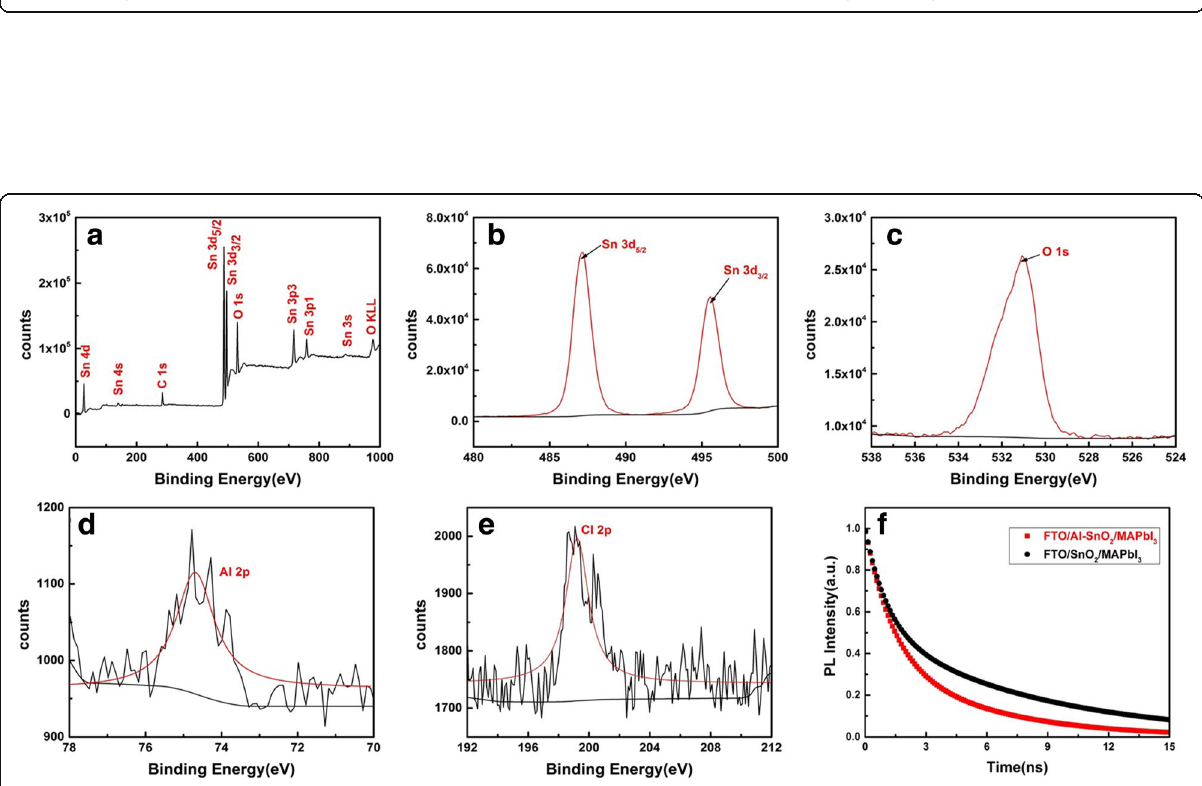
Fig. 2 a UV-vis absorbance spectra and b XRD patterns of perovskite films grown on SnO2 and Al-SnO2 substrates. c EQE curves and integrated current density of perovskite solar cells based on SnO2/Al-SnO2 and d J-V curves of the best-performing PSC using SnO2/Al-SnO2 ETLs